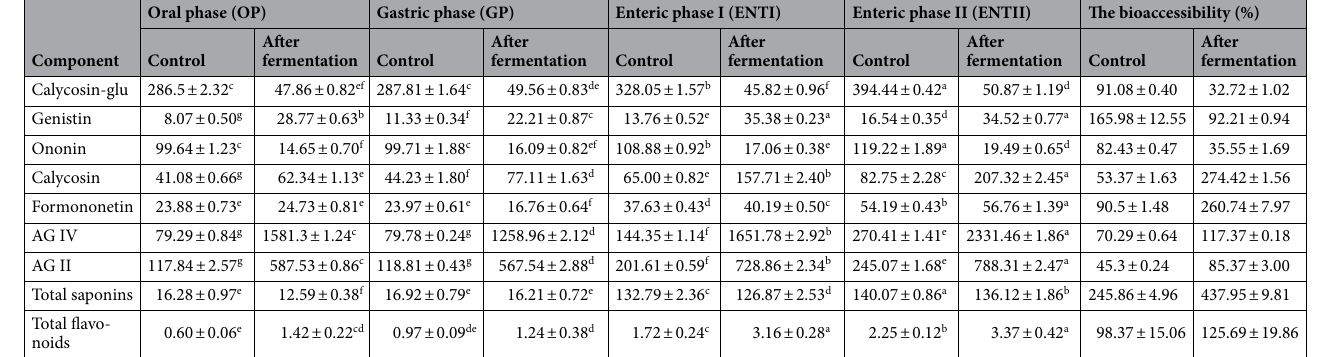
Table 4. Compounds contents of FRA and control during different in vitro digestion stages and bioaccessibility. Values are expressed as mean ± standard error from three replications. Means with different superscripts in the same row show significant difference (P < 0.05). Unit of calycosin-glu, genistin, ononin, calycosin, formononetin, AG IV and AG II here is μg/g. Unit of total saponins and total flavonoids here is